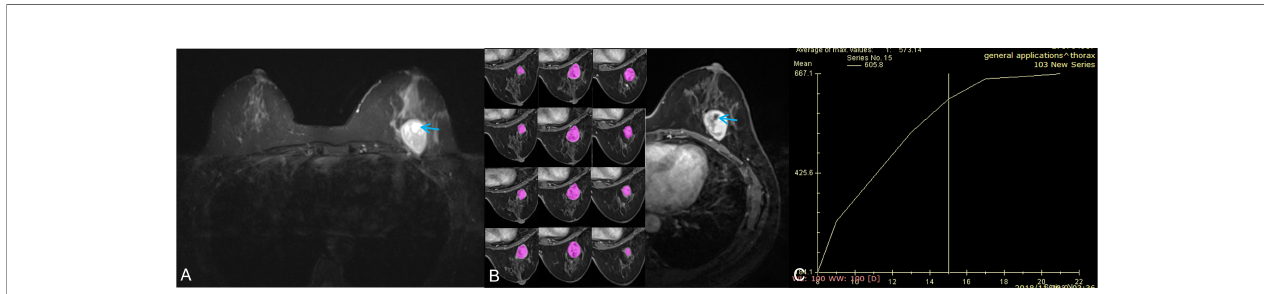
FIGURE 3 | A 42-year-old woman with a benign phyllodes tumor. (A) Axial T2WI showed a heterogeneous mass in the left breast, with a regular wall of cystic area (red arrow). (B) Axial DCE-MRI showed the mass with heterogeneous enhancement and non-enhancement cystic area; the segmentation of VOI was shown on the left series images. (C) The time-intensity curve was type II (plateau